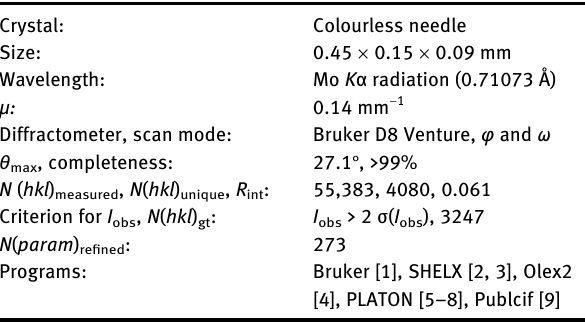
Table 1 contains crystallographic data and Table 2 contains the list of the atoms including atomic coordinates and displacement parameters.